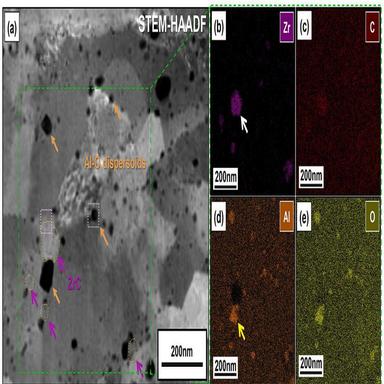
Observation of Fe-13Cr-3.5Al-2.0Mo-0.5 wt% ZrC: (a) STEM-HAADF image, (b) EDS mapping of Zr (c) C (d) Al (e) O.